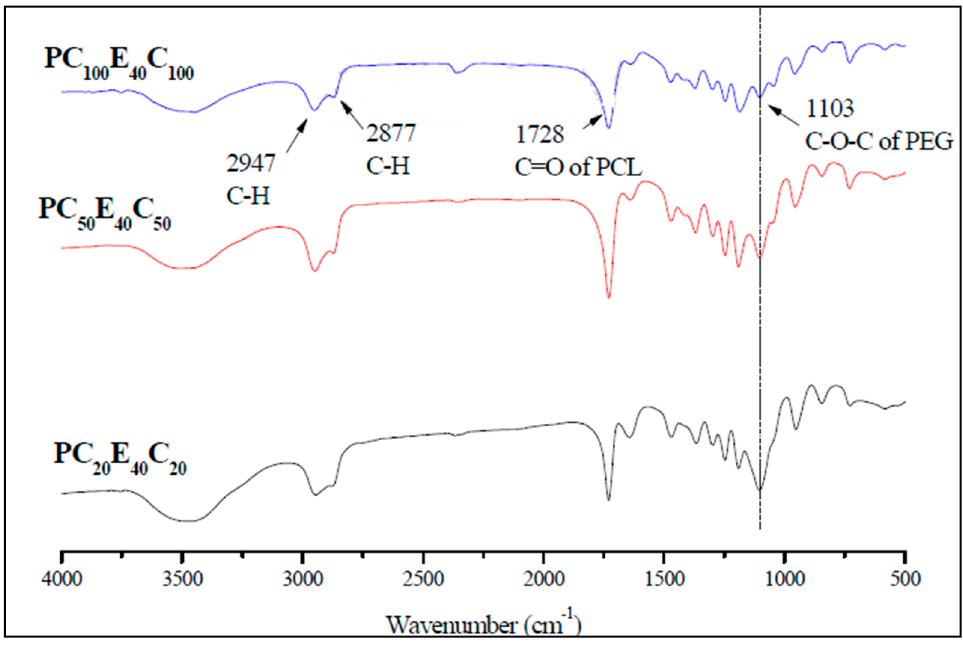
Figure 1. Fourier-transform infrared spectra of three PCL-PEG-PCL copolymers. The polymers were pelleted with KBr for transmission measurement. The Y -axis indicates the transmittance (%). Table 2. Molecular weights of PCECs and critical micelle concentration (CMC). The first column displays the theoretical molecular weights of the PCECs. All molecular weights are expressed asg/mol. M NMR a M n